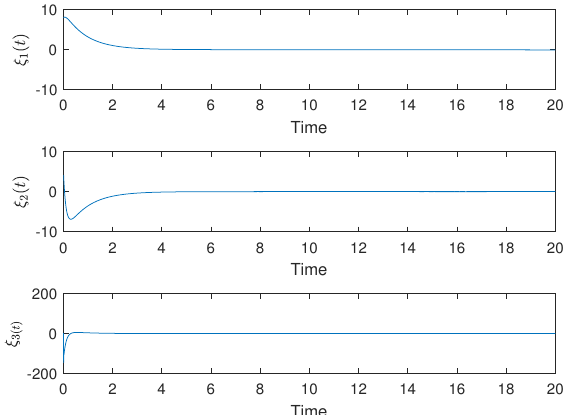
Figure 2. The convergence of three tracking errors ξ 1 , ξ 2 and ξ 3 .